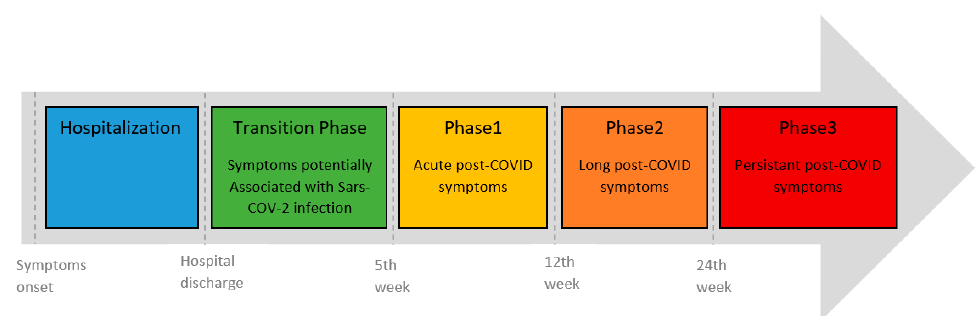
Figure 1. Integrative model of post-COVID symptoms in hospitalized patients showing the Transition Phase (green) and Phases 1 (yellow), 2 (orange) and 3 (red) of post-COVID symptoms [11].